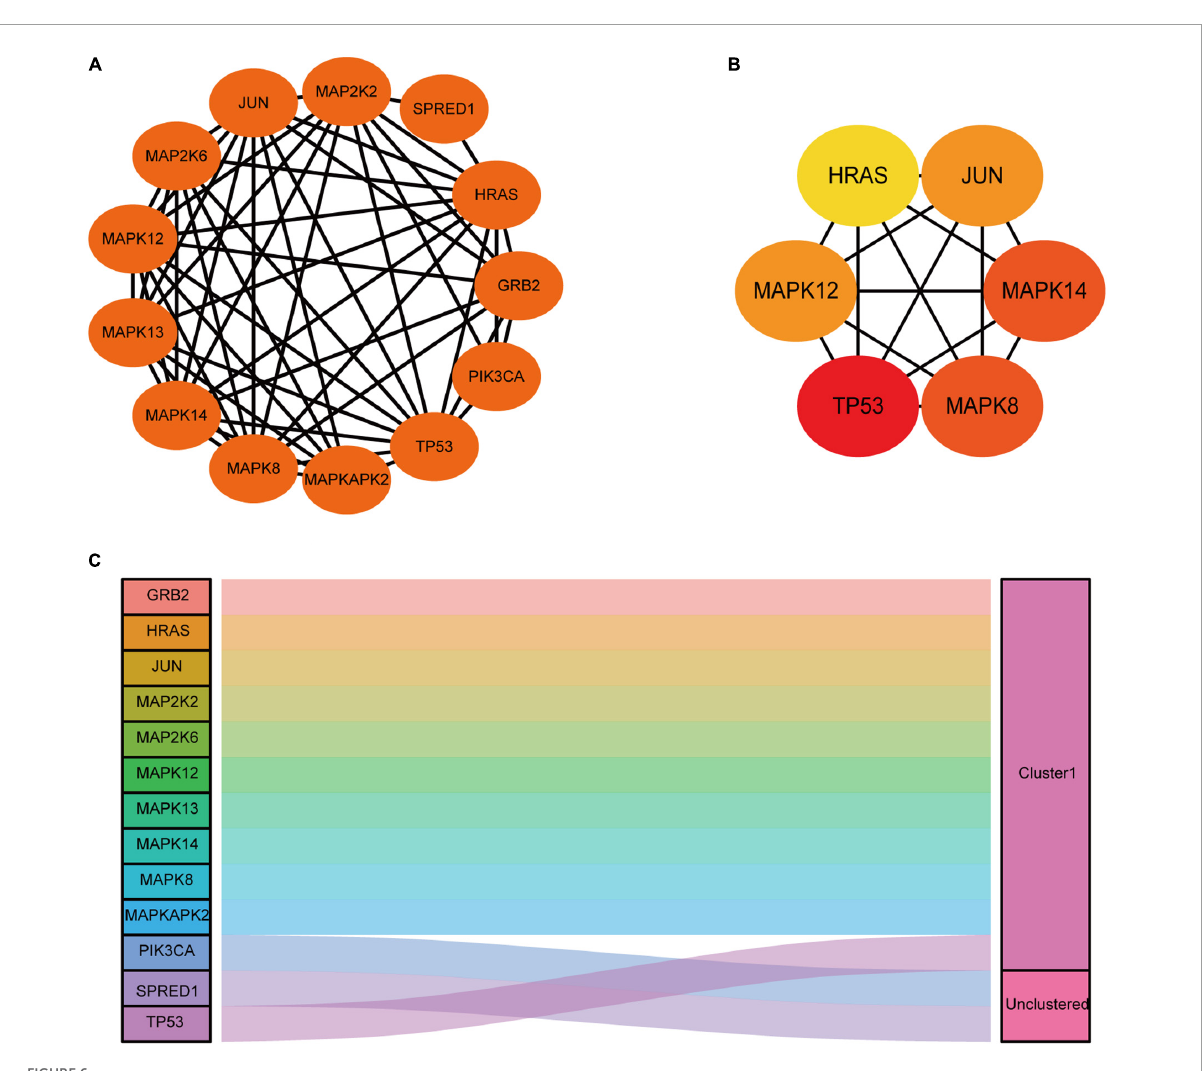
FIGURE6 Construction of functional networks and identification of candidate genes and module analysis. (A) Functional protein-protein interaction (PPI) network analysis of the 13 differentially expressed genes (DEGs). (B) Subnetwork of top six hub genes from the PPI network. Node color reflects the degree of connectivity (Red color represents a higher degree, and yellow color represents a lower degree). (C) One module was identified by ggalluvial in R and was visualized by